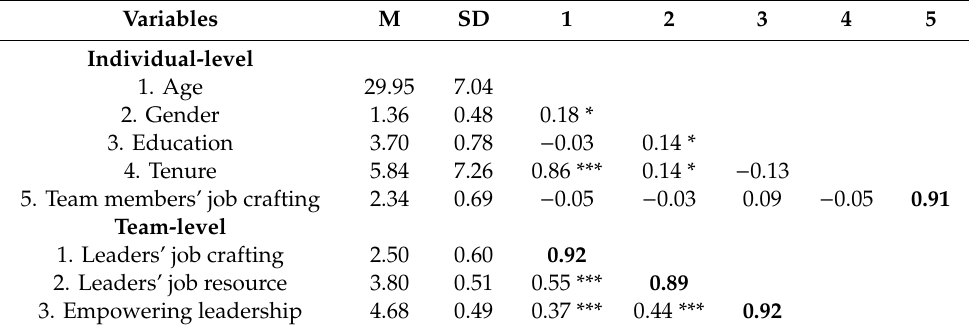
Table 1. Mean, standard deviations, and correlation